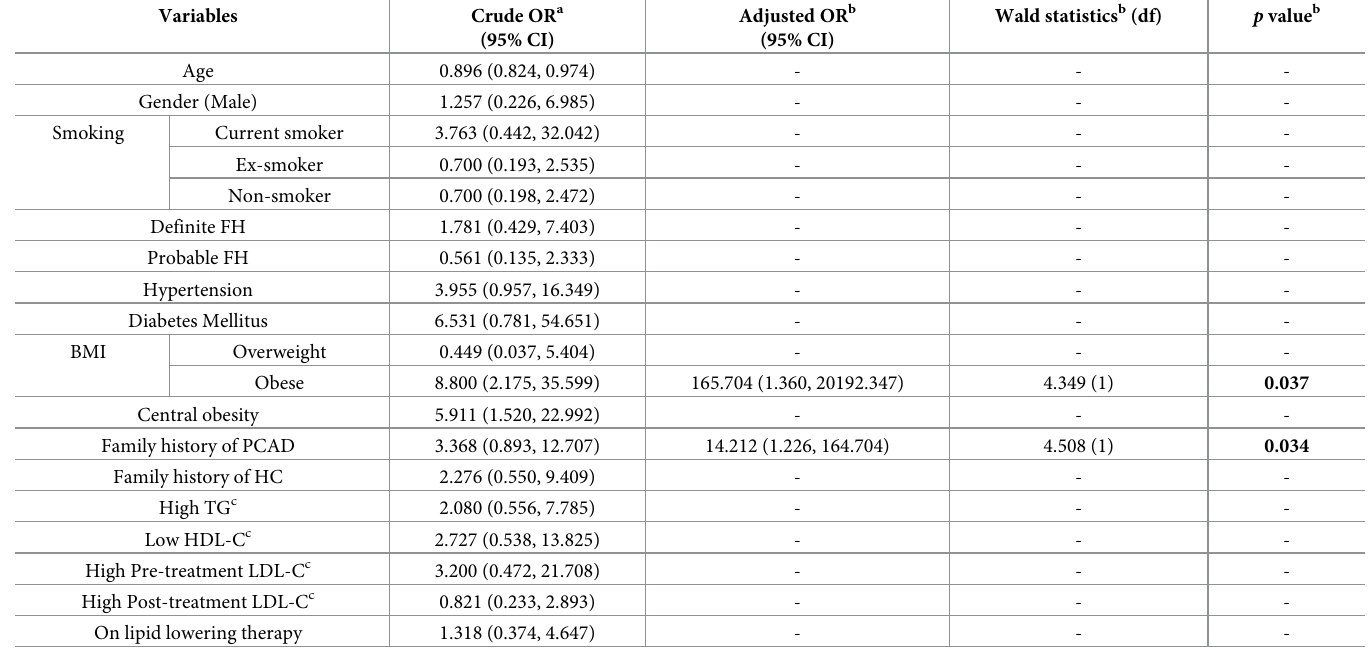
a Simple logistic regression b Multiple logistic